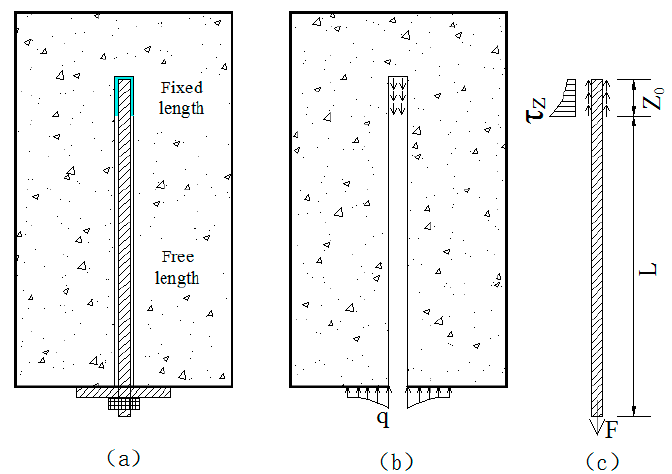
Figure 6. Mechanism of the prestressed anchor. ( a ) the schematic of “rock bolt—surrounding rock” supporting structure, ( b ) the force schematic of the surrounding rock, ( c ) the force schematic of the bolt-shaft.